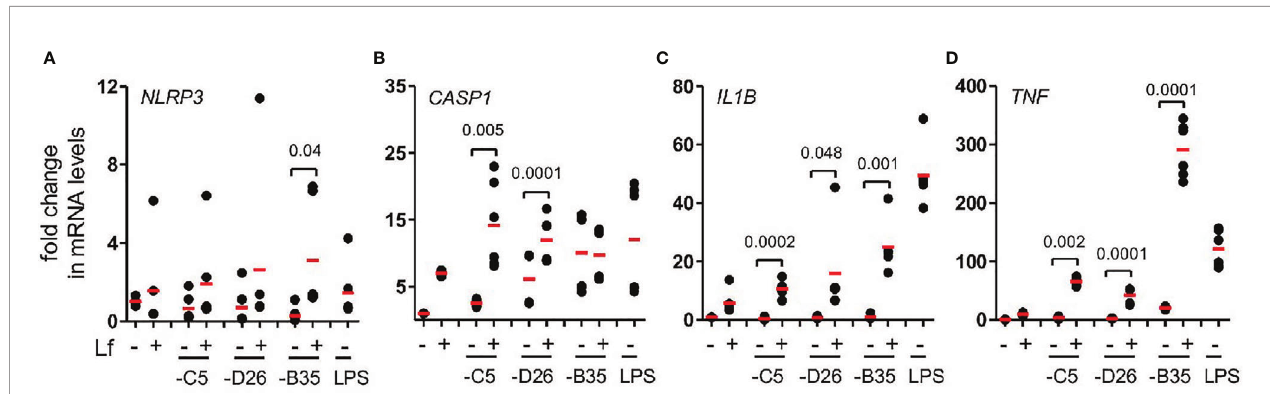
FIGURE 4 | HAdV-lactoferrin complexes induce IL-1 b via an NLRP3 in fl ammasome mRNA levels of in fl ammasome components were analysed using qRT-PCR 4 h post-incubation. Total RNA was isolated from DCs and cDNA samples were analysed in triplicate. The GAPDH mRNA was used as an internal standard. (A) NLRP3 ; (B) CASP1 , (C) ( IL1B and (D) TNF ; (n ≥ 3, statistical analyses were by two-tailed paired